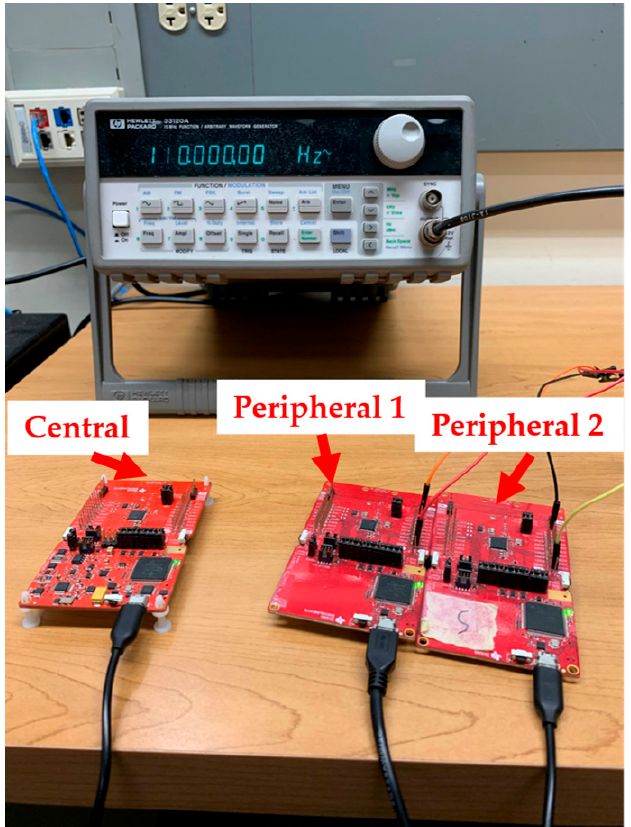
Figure 2. TI platform (one central node and two peripheral nodes) and the Hewlett Packard 33120A signal generator. The signal generator sine wave output is simultaneously connected to the ADC input of both peripheral nodes.